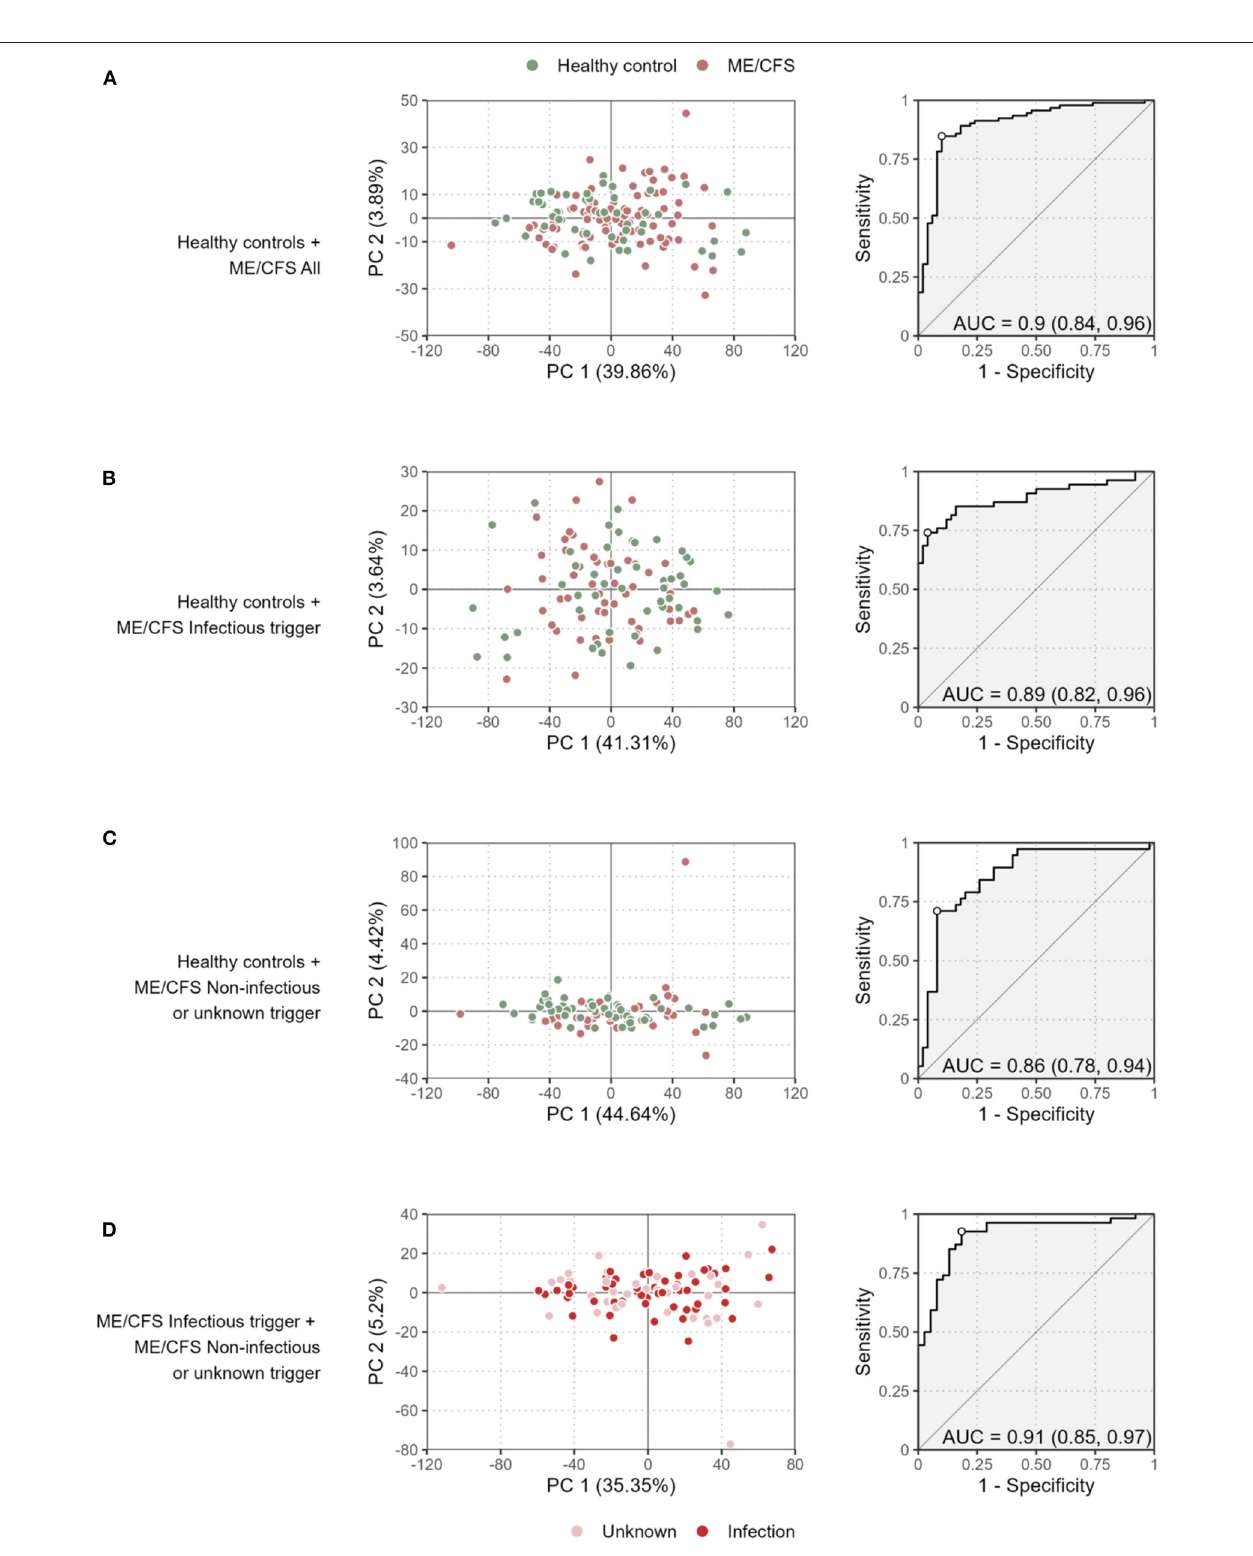
FIGURE 1 | Preliminary multivariate analysis of the data. Scatterplots of the first two principal components (left plots) and the ROC curve and its AUC of the respective LDA (right plots) when comparing all the ME/CFS patients to healthy controls (A) , ME/CFS patients with an infectious trigger to healthy controls (B) , ME/CFS patients with a non-infectious or unknown trigger to healthy controls (C) , and ME/CFS patients with an infectious trigger to the remaining patients (D) . The percentage of the variance explained by each principal component is shown in each axis within brackets.